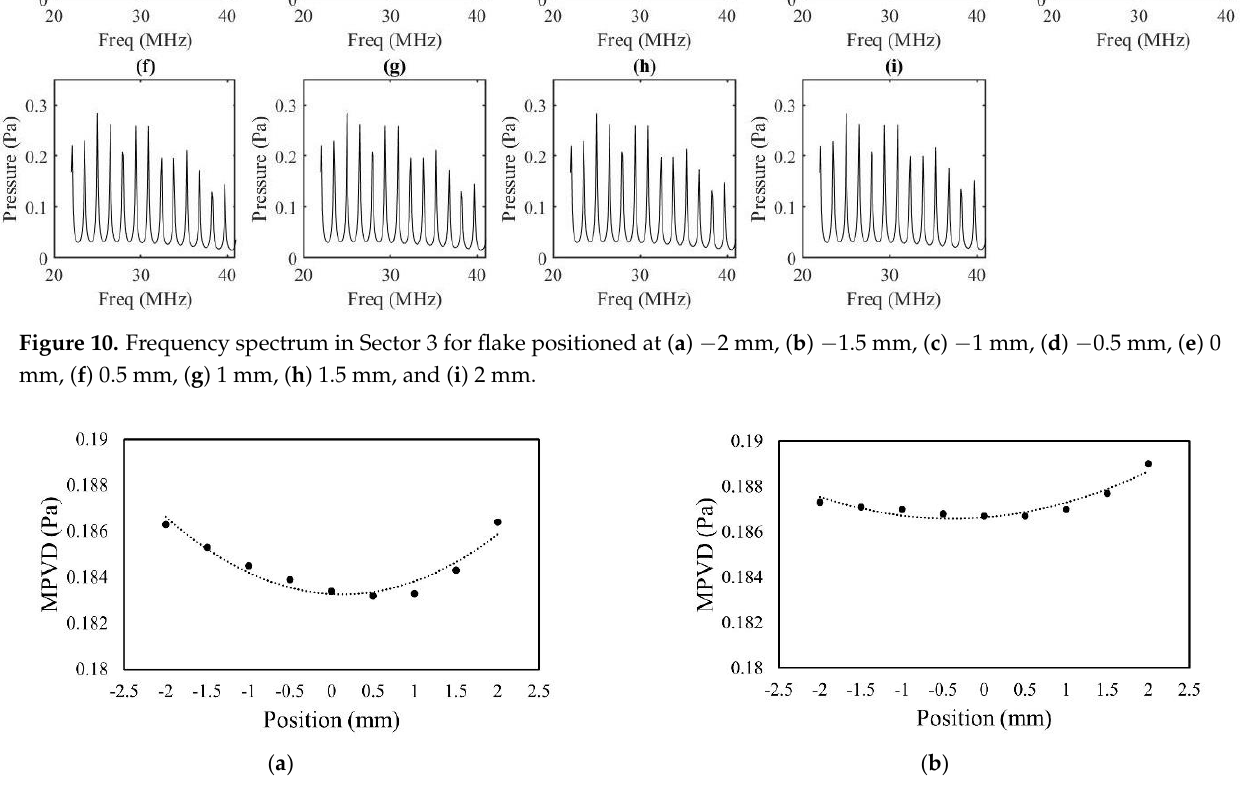
Figure 11. MPVD value at all flake positions in ( a ) Sectors 2 and ( b ) 3.